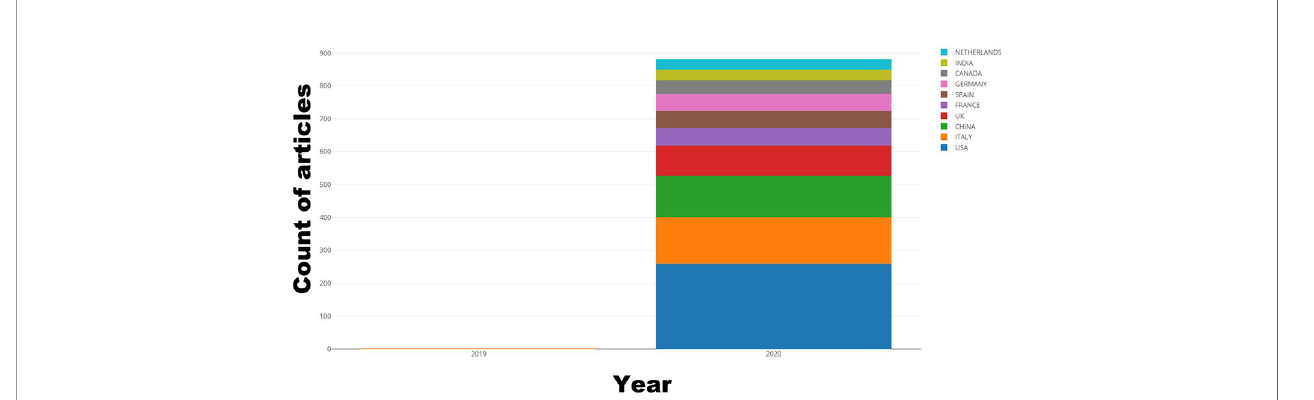
FIGURE 1 | The distribution of countries/regions. The development of the top 10